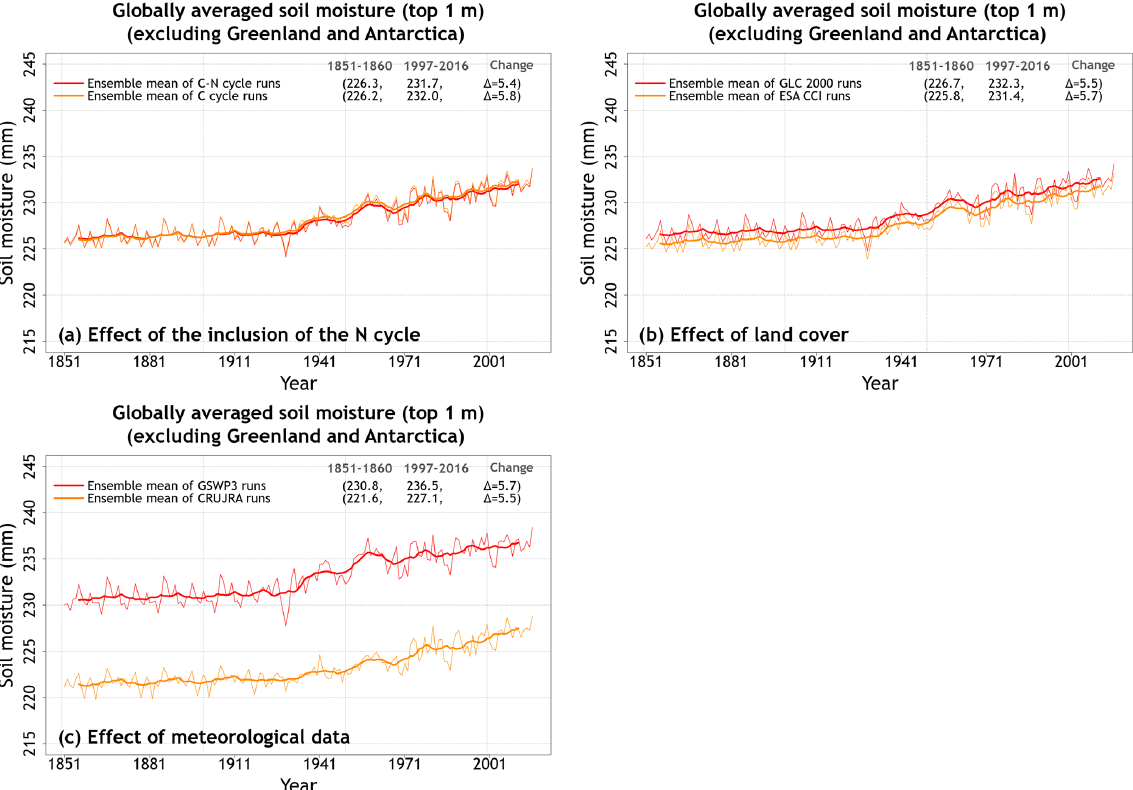
Figure 2. Time series of annual globally averaged soil moisture in the top 1m averaged over the four ensemble members that are driven with and without an interactive N cycle (a) , that are driven with the GLC-2000- and ESA-CCI-based land cover representations (b) , and that are driven with the GSWP3 and CRU-JRA meteorological data (c) . The thin lines show the individual years, and the thick lines show their 11-year moving average. Model values averaged over the pre-industrial (1851–1860) and present-day (1997–2016) time periods, and their difference, for each ensemble averaged over its set of four simulations are also